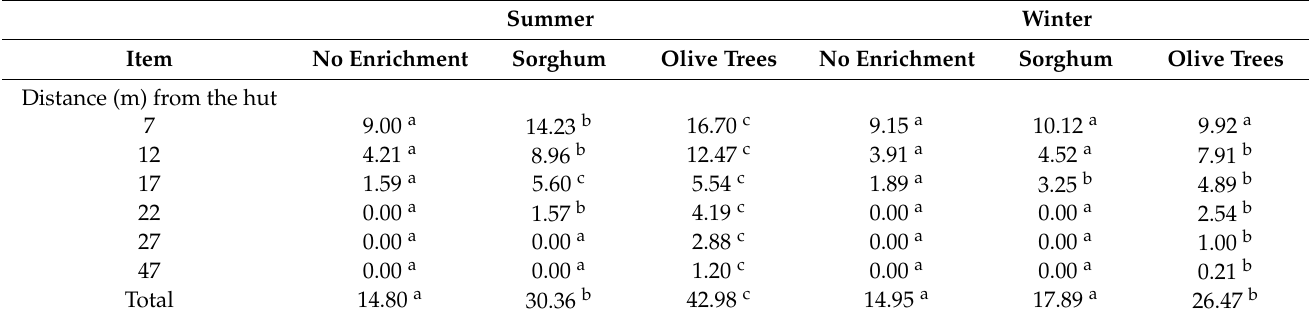
Table 6. Estimated grass intake of chickens (g of dry matter/d per bird). Modified from [31]. Summer Winter No Enrich- Olive No Enrich- Olive Item Sorghum Sorghum ment Trees ment Trees Distance (m) from the hut